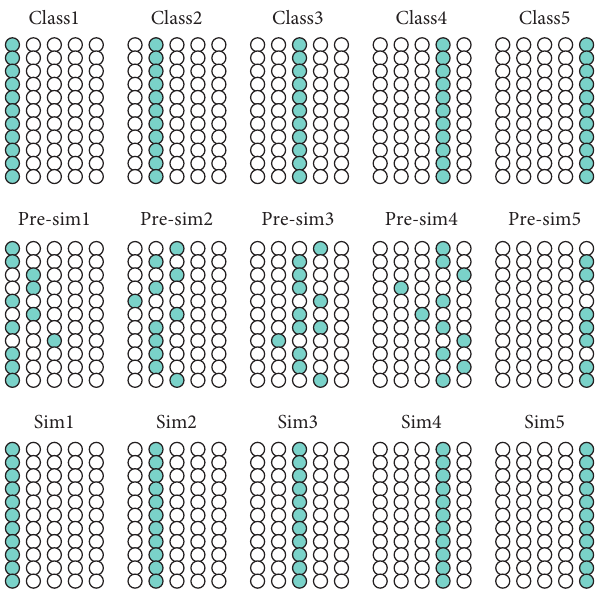
Figure 5: Simulation results of five national higher education evaluation index